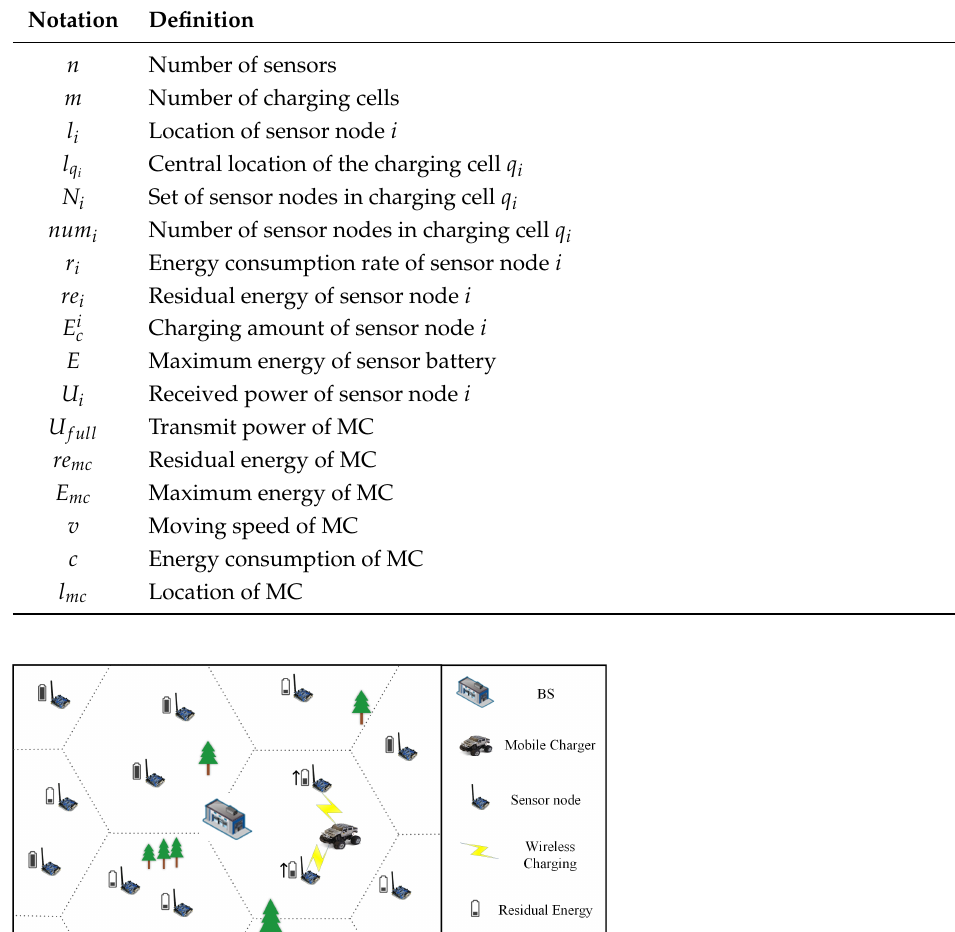
Table 2. List of important notations .